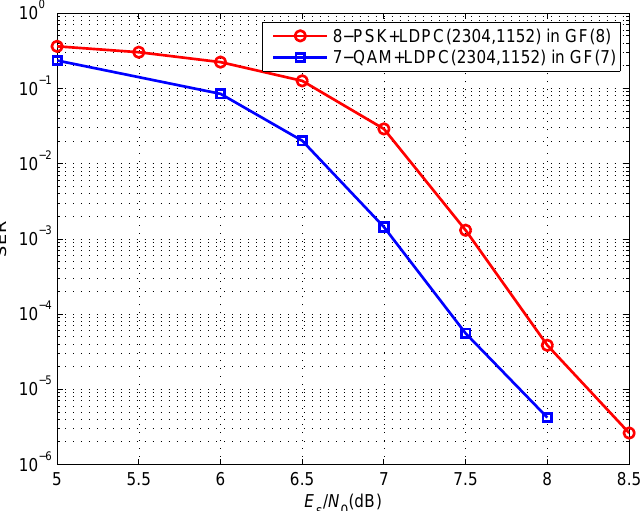
Figure 7. SER of different modulations combined with NB-LDPC codes over the AWGN